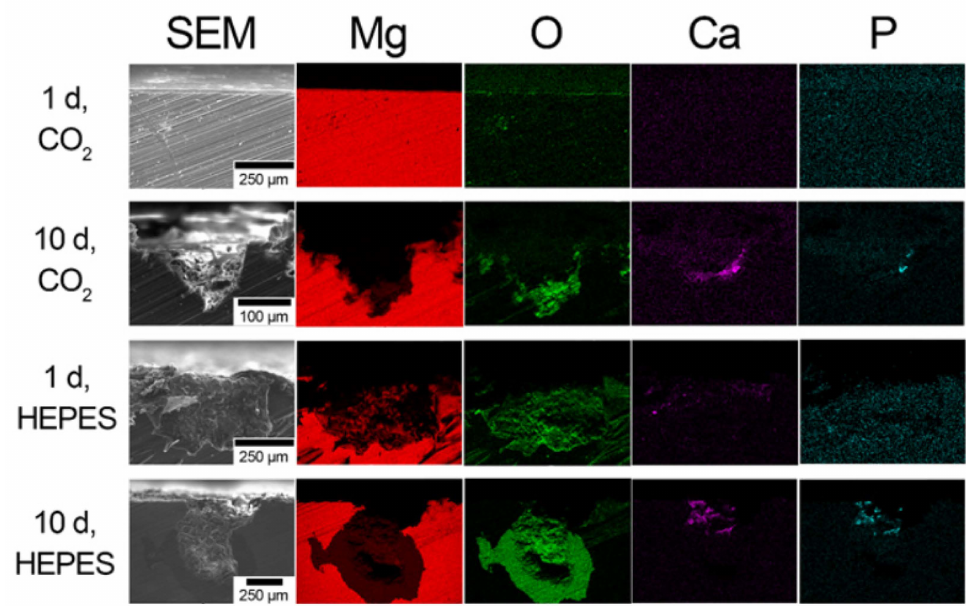
Figure 5. Scanning electron micrographs and corresponding elemental EDS maps taken from the cross-section (transverse plane) of AC as a function of the buffer system and immersion time in EBSS.